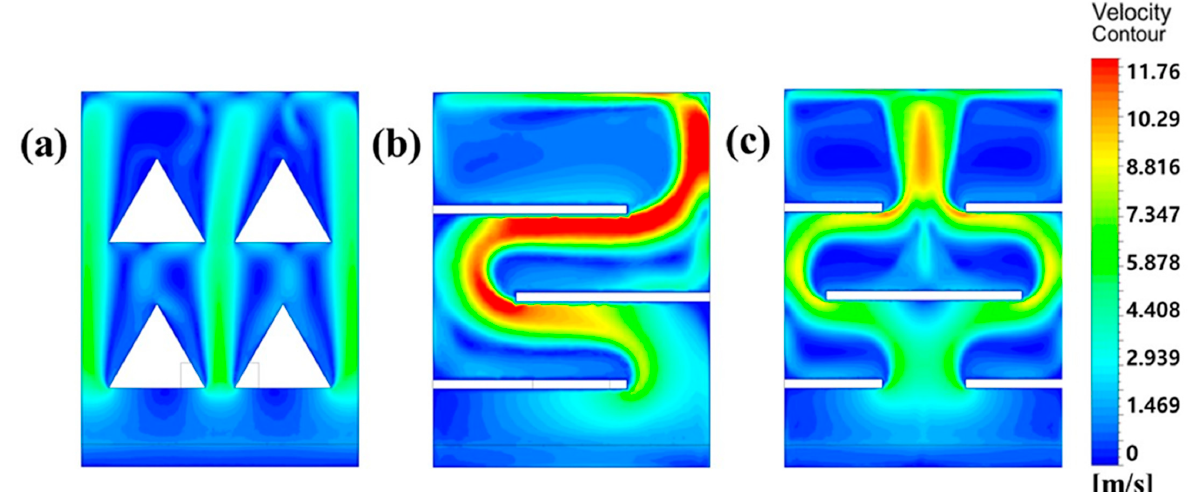
Figure 5. Airflow velocity distribution of solar air heater. ( a ) Model 1, ( b ) Model 2, ( c ) Model 3.